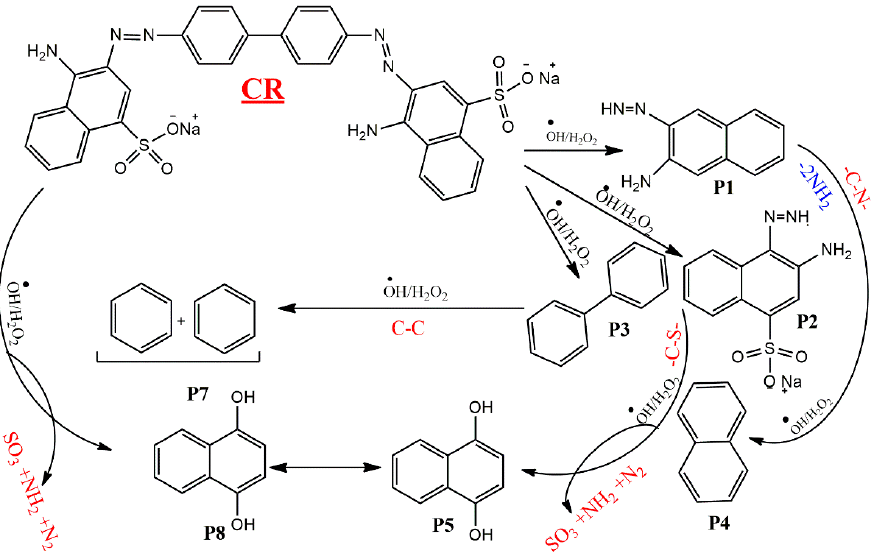
Scheme 1. Proposed mechanism of degradation of Congo red